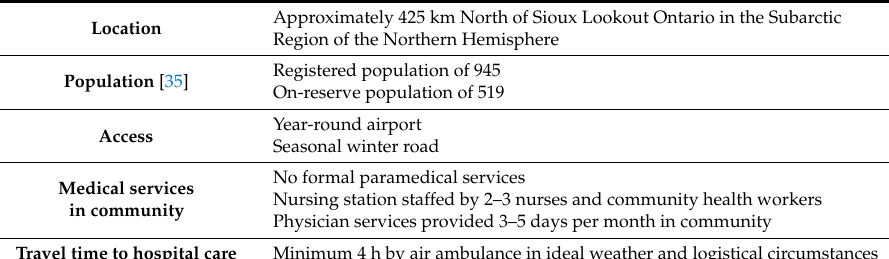
Table 1. Characteristics of Sachigo Lake First Nation.